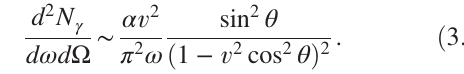
FIG. 10. The angular spectrum d 2 N γ =d ω d Ω at ω ¼ 1 eV (left) and the energy spectrum dN γ =d ω (right) of transition radiation, for an electron passing a copper-vacuum interface. We present the spectra for three choices of electron energies: E ¼ 1 MeV (orange lines), and E ¼ 100 keV (green lines). Solid lines show the rate for forward emission (electron moving from E e e copper to vacuum), while dashed lines show the rate for backward emission (electron moving from vacuum to